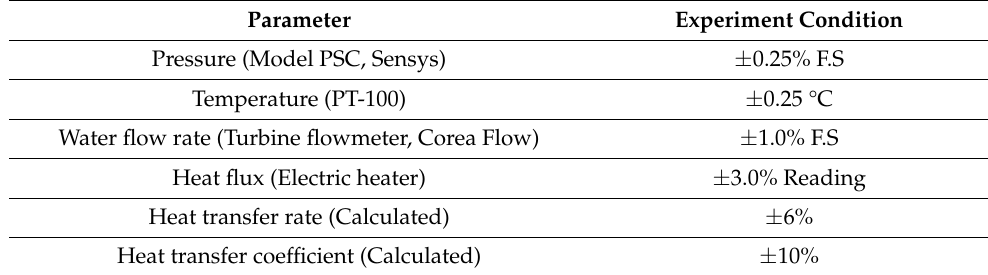
Figure 4. Schematic diagram of multi-stream PFHE experimental apparatus. Table 2. Uncertainties in measured and calculated